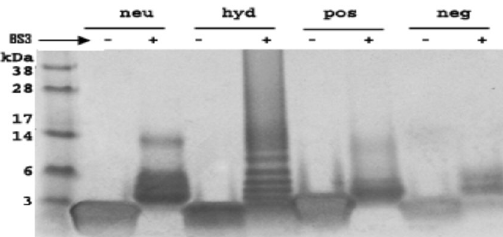
Figure 2. Cross-linking of ELKs. Cross-linking of ELKs with ( + ) or without ( − ) excess BS 3 (bis[sulfosuccinimidyl] suberate) followed by SDS-PAGE (12% Tris-Tricine gel) electrophoresis. An uncropped image of the electrophoresis gel for Fig. 2 is shown in Supplementary Figure